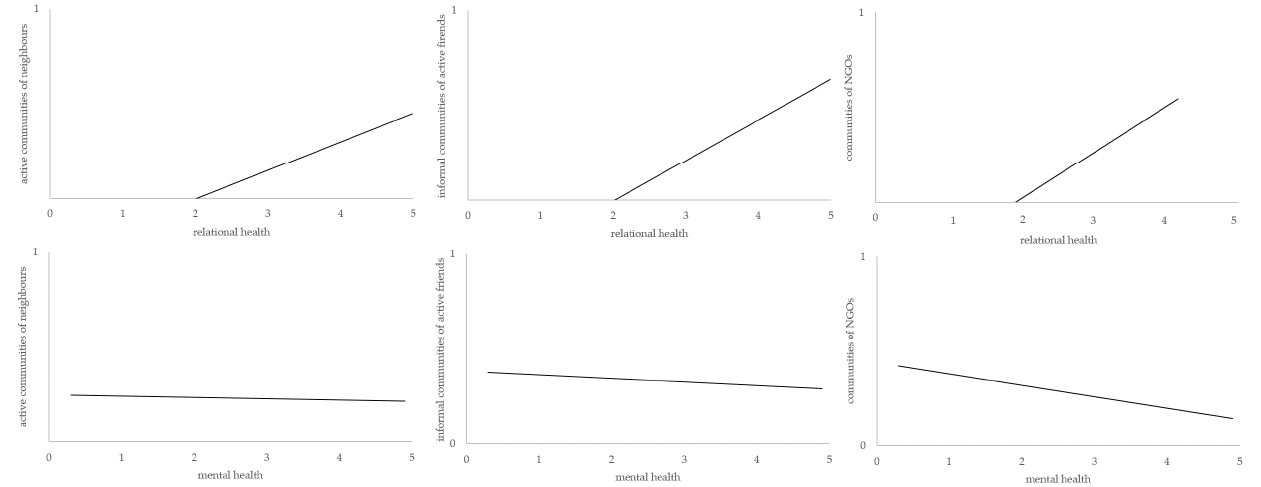
Figure 3. Prediction of linear relationships between several factors of community engagement, rela- relational and mental tional and mental health.